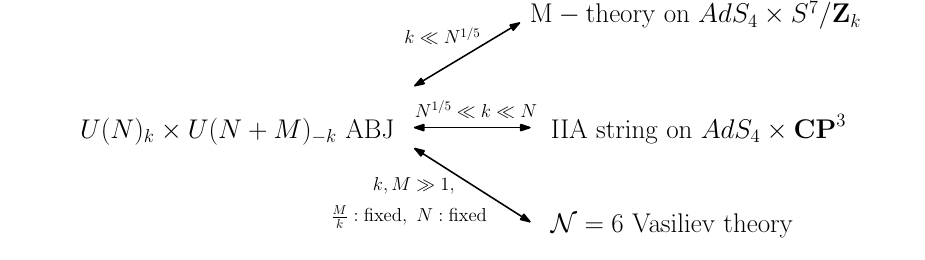
Figure 1 . Summary of the